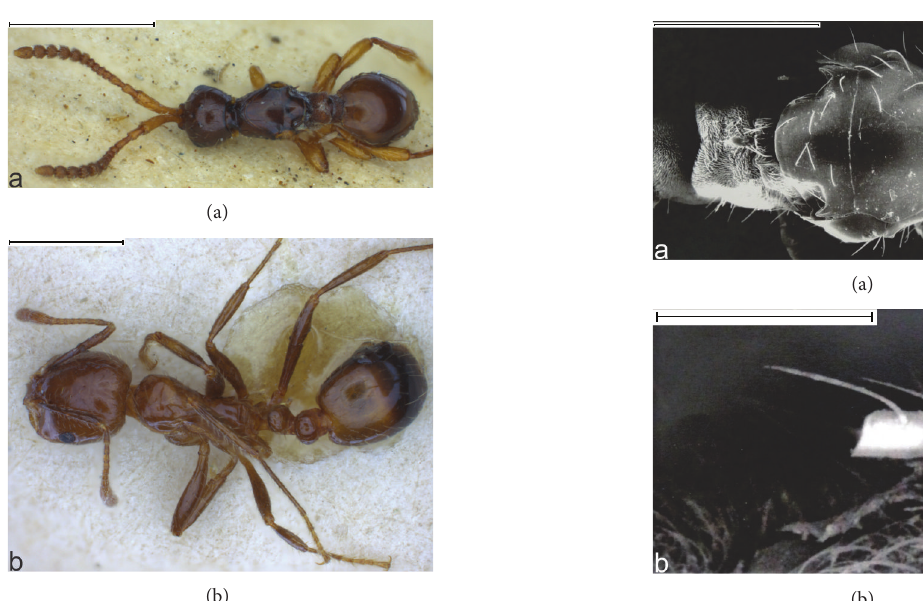
Figure 10: Bruchopria hexatoma female. (a) mesosoma and petiole in dorsal view, scale: 0.5 mm; (b) wing stump, scale: 0.1 mm